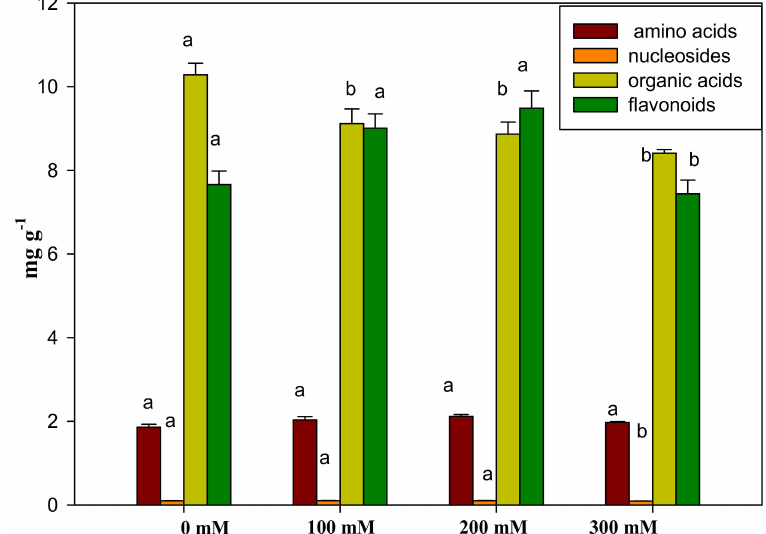
Figure 3. The accumulation of four kinds of constituents in AVF under salt tolerance. Bars are expressed as the mean ± SD ( n = 3). Bars carrying different letters are significantly different at p < 0.05 among NaCl